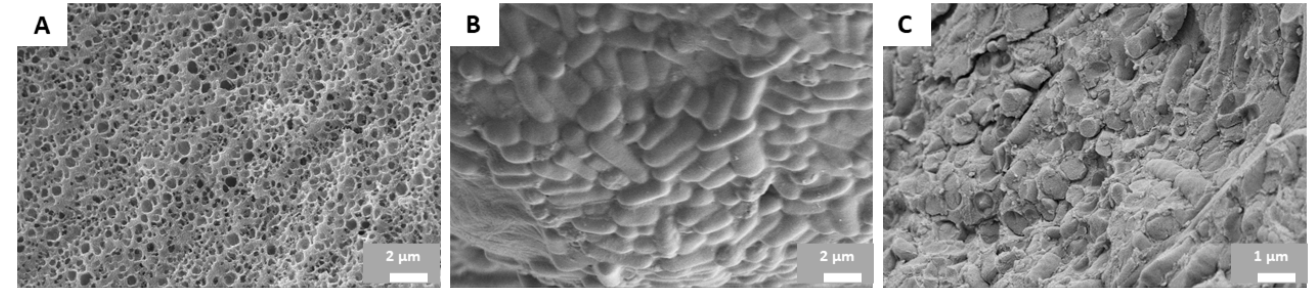
Figure 1. SEM of F127-BUM colloids with and without T15. F127-BUM colloids ( A ), Surface microto- pography of F127-BUM colloids with T15 immobilizztion ( B ), Sectional view of F127-BUM colloids with T15 immobilization ( C ).